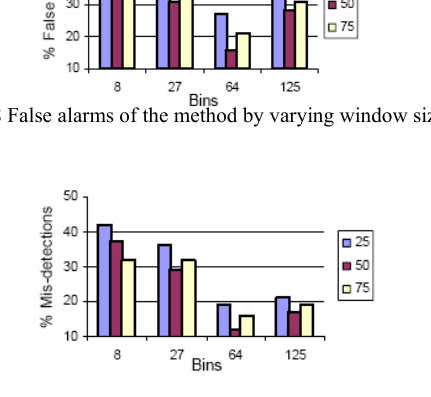
Fig. 9 Mis detections shown by the method while varying window size and bins.